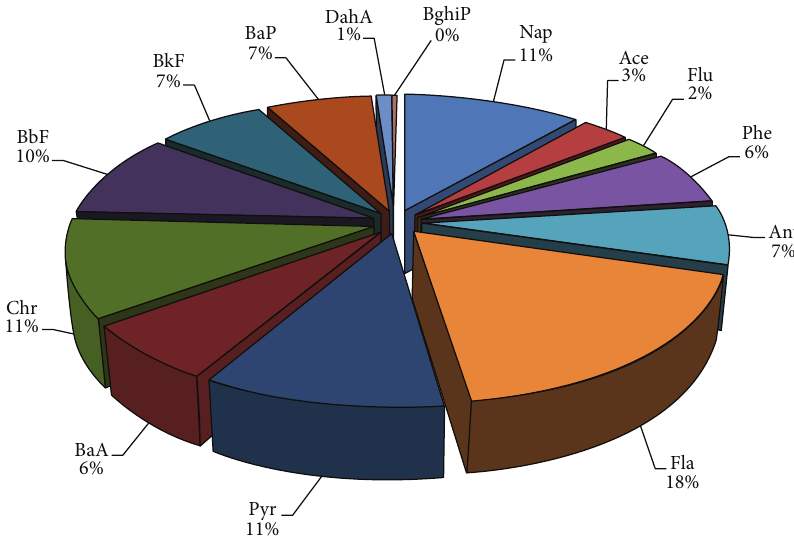
Figure 3: The total average distribution of individual PAHs in